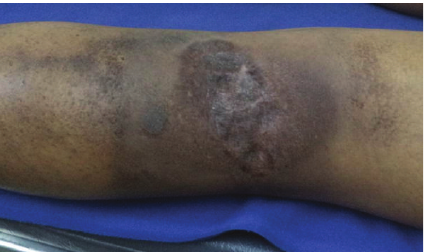
Figure 4: Postirradiation photograph of the left popliteal fossa, there was no joint dysfunction as tangential fields were used in delivering